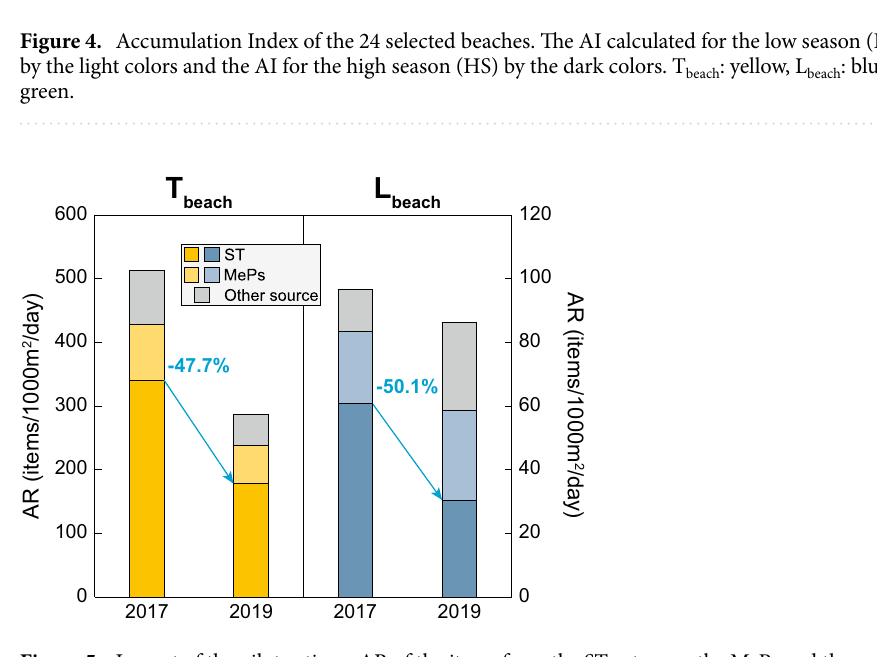
Figure 5. Impact of the pilot actions. AR of the items from the ST category, the MePs and the remaining items (excluding MPs and pellets) measured in August/September2017 and in August/September 2019 after the implementation of the pilot actions. The light blue percentages provide the decrease of the AR for the ST category between 2017 and